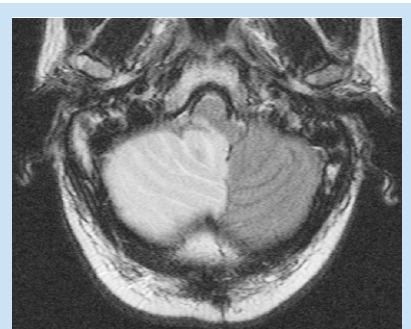
Fig. 3. Axial T2-weighted image shows the classic findings of a right hemi-cerebellar lesion with lam- inated hypertrophic folia and alternating curvilinear bands of high and low signal intensity. Similar find- ings were noted on the fluid attenuated inversion recovery (FLAIR)